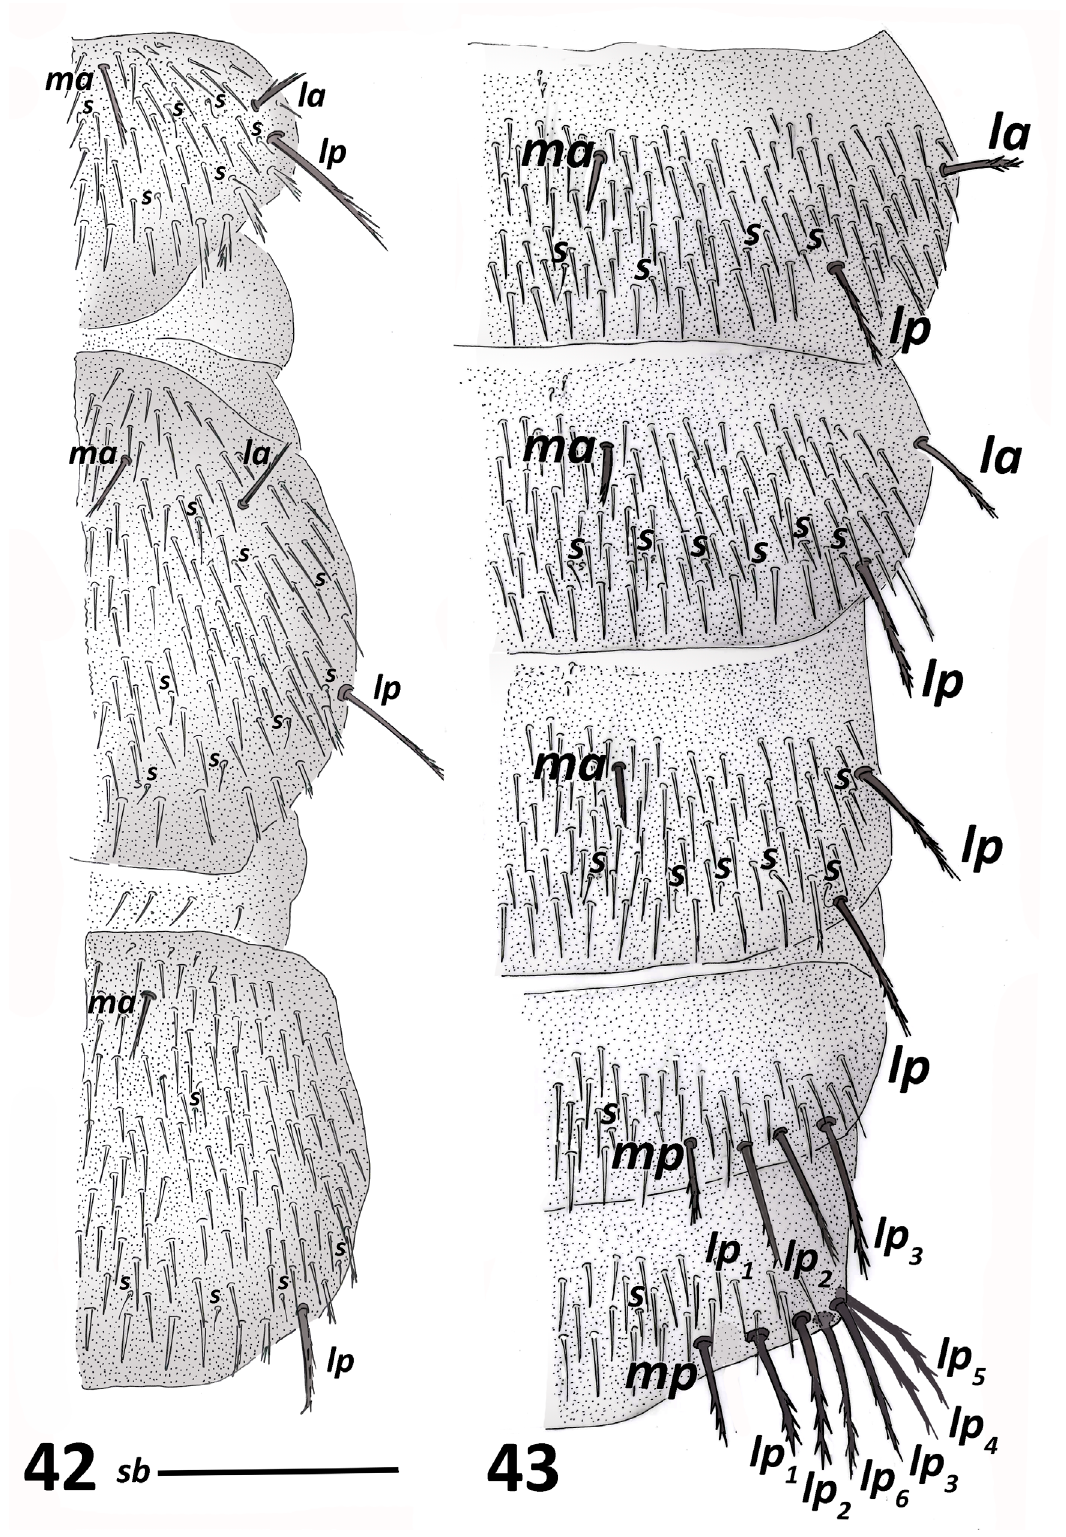
Figs 42–43. Campodea ( Campodea ) meinerti Bagnall, 1918, ♀, 4.4 mm, from Pichoy, France. 42 . Pronotum, mesonotum and metanotum. 43 . Urotergites V–VII and abdominal segment IX. Abbreviations: see Material and methods. Scale bar: 0.2